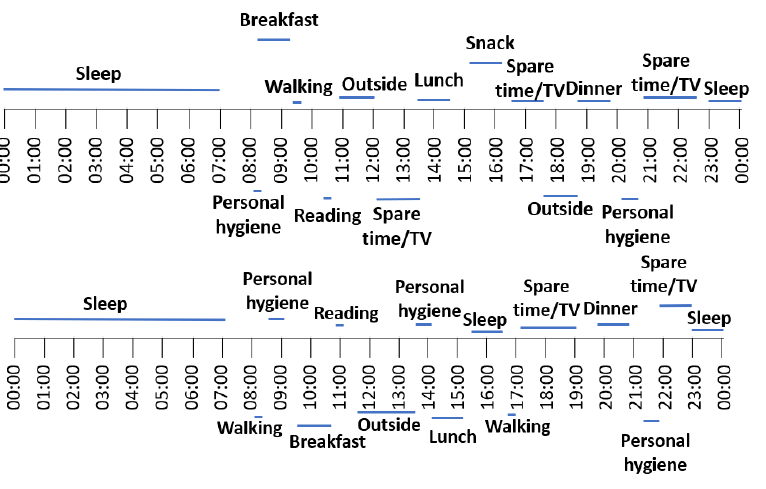
Figure 11. The best-ranked routines considering the fitness value for the person with id 6. The duration interval corresponding to each activity in each period of the day (i.e.,